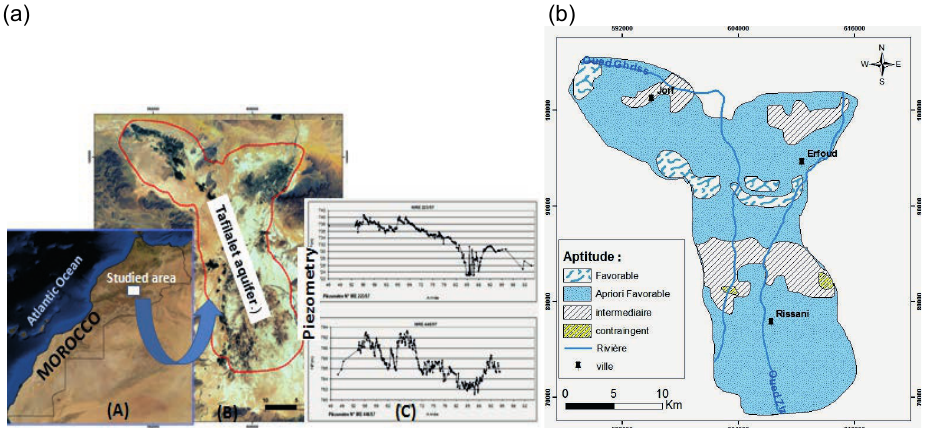
Fig. 2 (a) Tafilalet aquifer location and piezometric evolution; (b) map of suitability for artificial recharge.